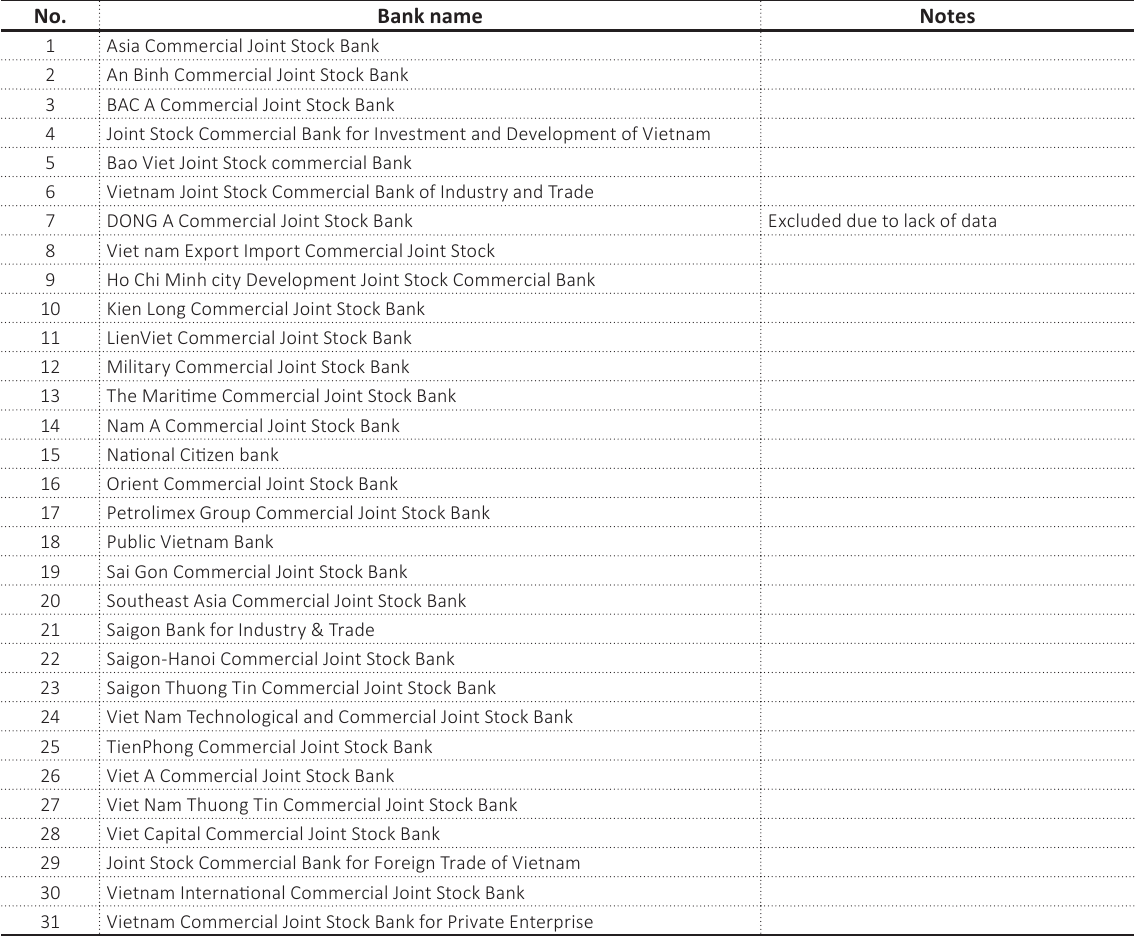
Source: State Bank of Vietnam.